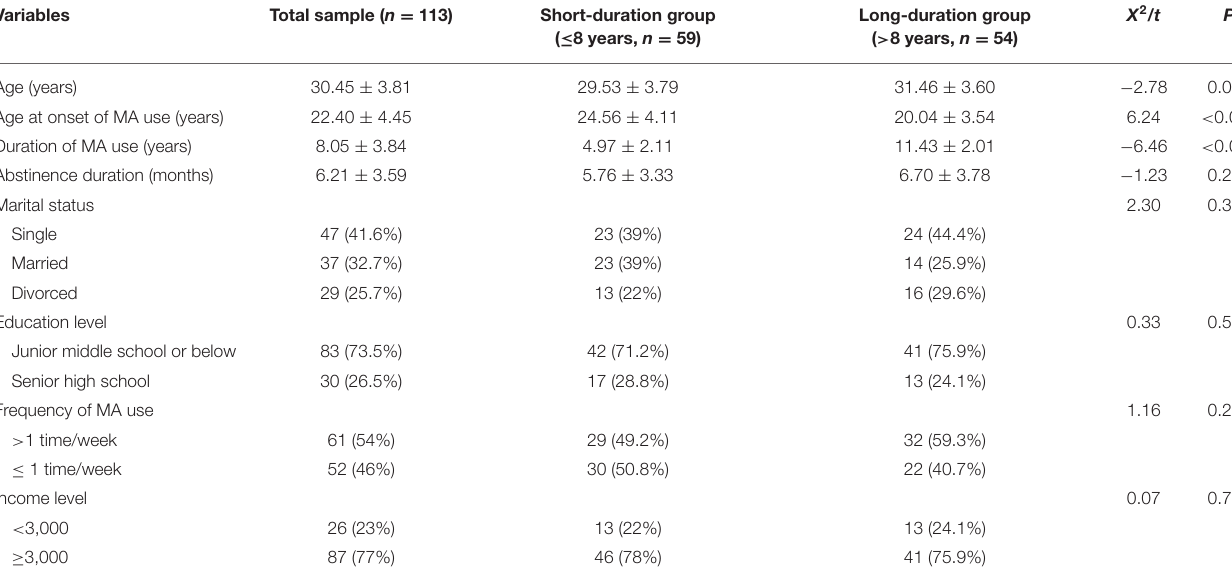
TABLE 1 | Comparison of the demographic characteristics between short-duration and long-duration groups. Variables Total sample ( n = 113) Short-duration group